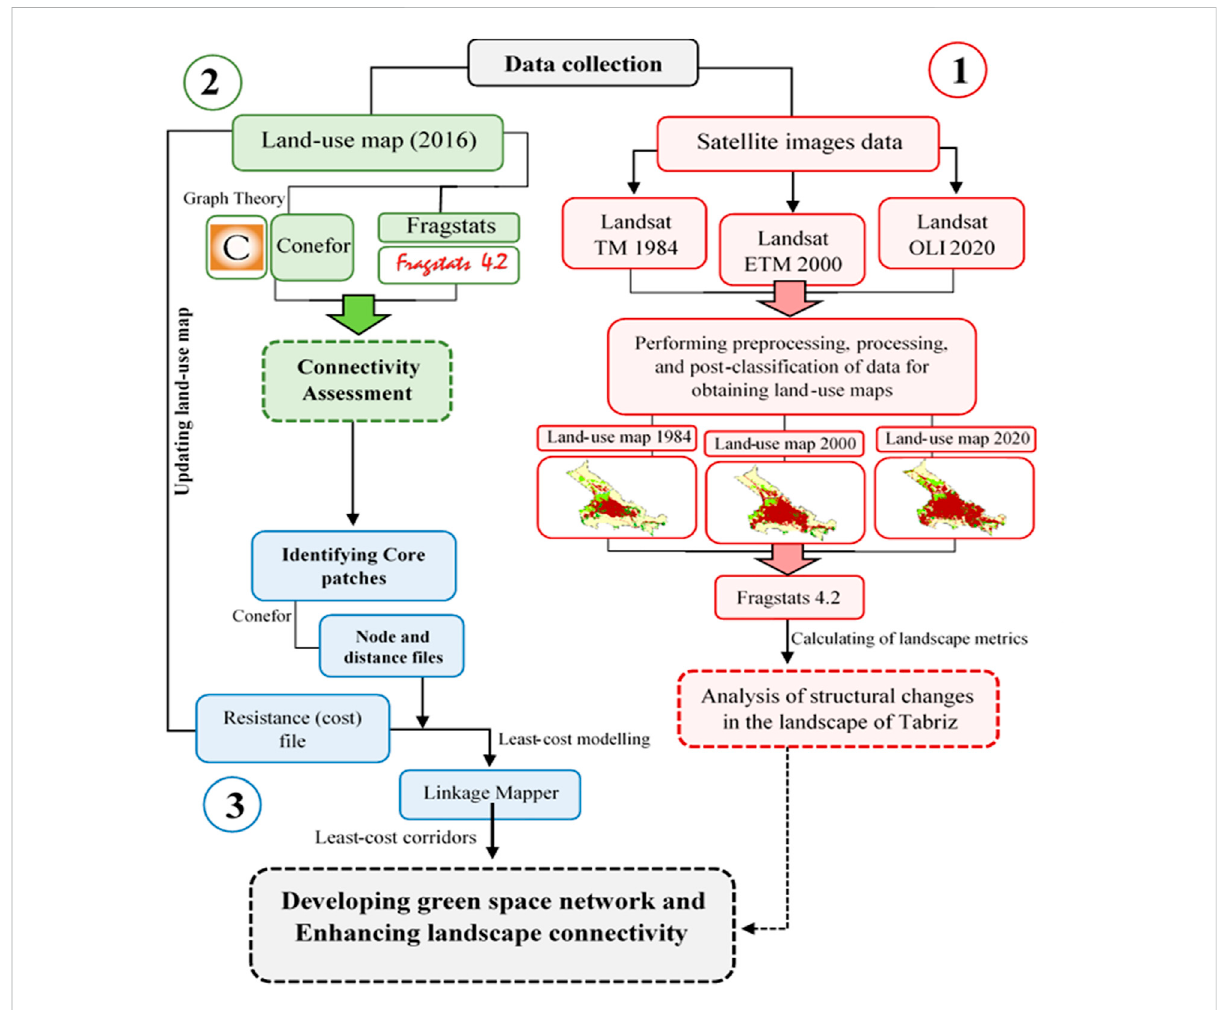
FIGURE 2 Schema of our methodological framework (main